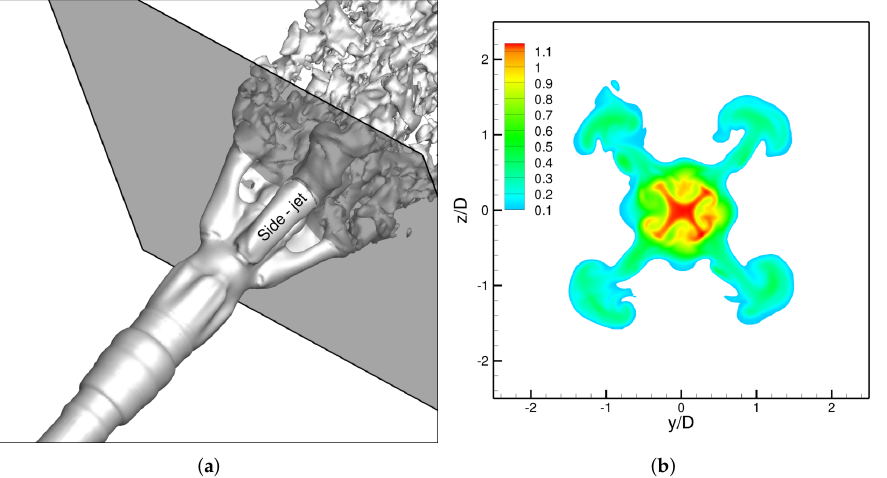
Figure 9. Iso-surfaces of the axial velocity U x / U 0 = 0.2 ( a ) and contours of axial velocity U x / U 0 at the plane perpendicular to the jet axis ( b ). The results are obtained for the case E − Car − Ti 0.01 .